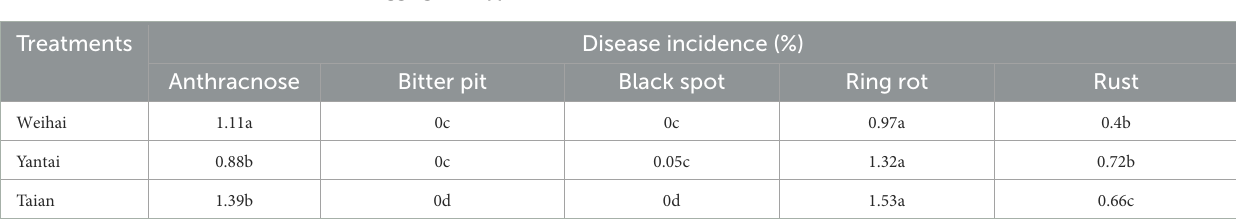
TABLE 3 Occurrence of different diseases in bagging-free apple.